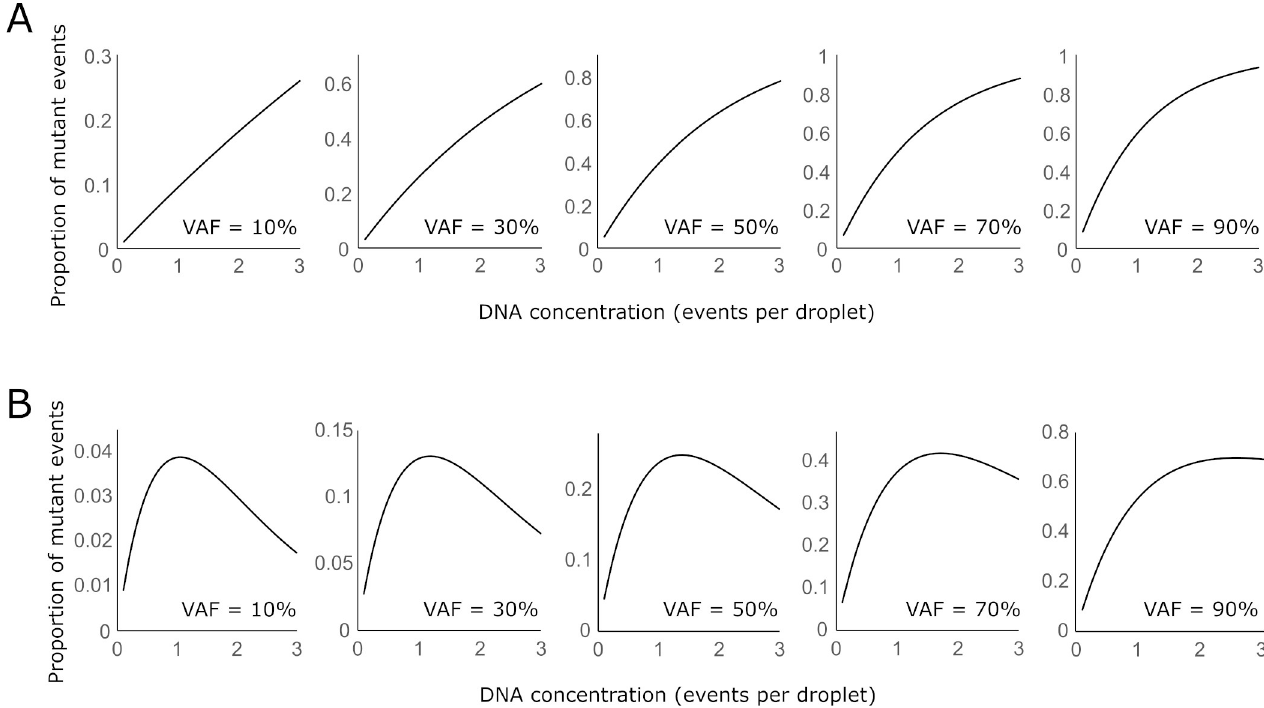
Fig 3. Relationship between variant allele fraction (VAF), DNA loading concentration, and positive mutation events for EGFR L858R (A) and EGFR exon 19 deletion